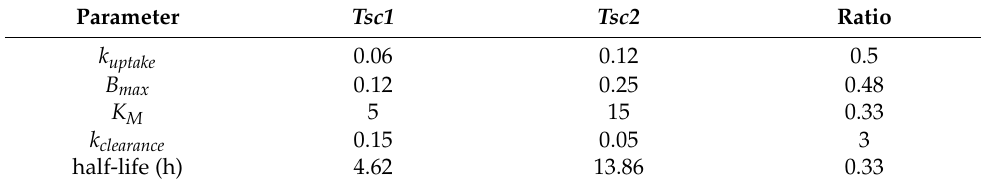
Table 2. Result table for mathematical modeling of the Tsc mutant-derived EV